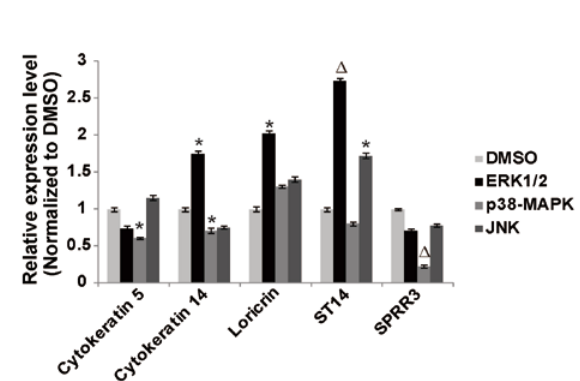
Figure 3: Inhibition of the MAPK pathway affected mRNA expression of differentiation-related proteins. qRT-PCR results of mRNA expres- sion of differentiation-related proteins. NHEKs were treated with 20 µM SB203580, 100 µM PD98059 or 50 µM SP600125, respectively. n = 3, * P < 0.05, ΔP <